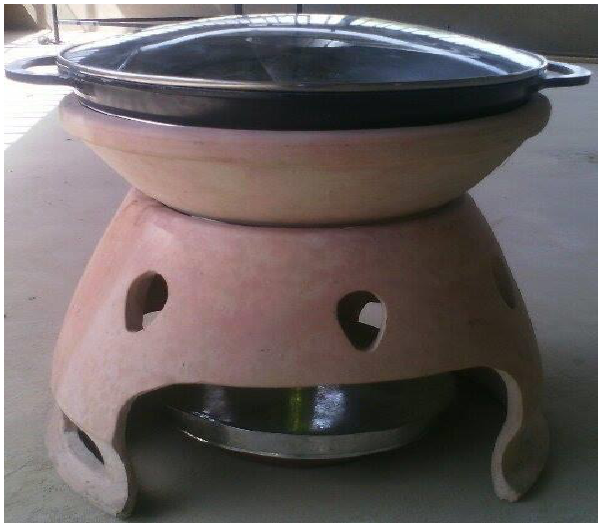
Fig. 1. Solar Water Desalination